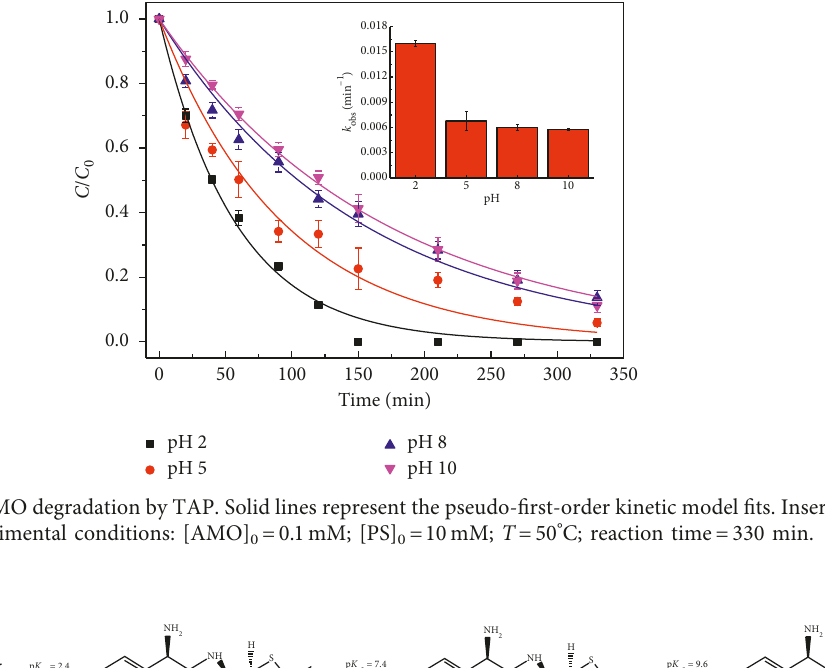
Figure 3: % RSE and TOC/TOC T � 50 ° C; reaction time � 330min.